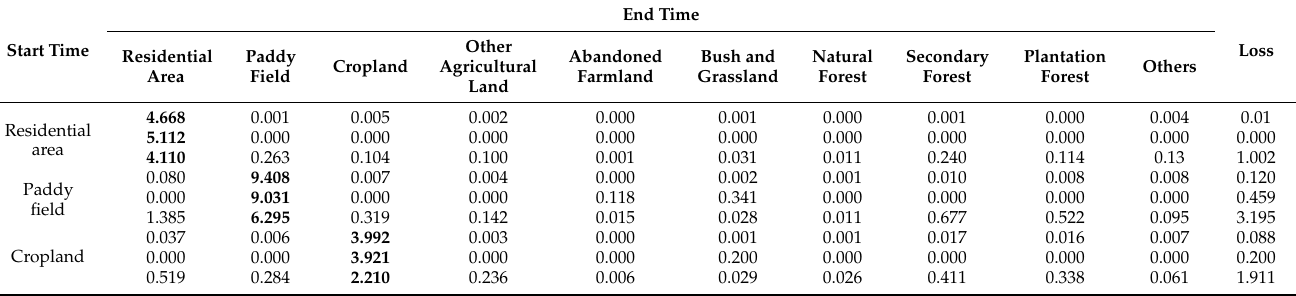
Table A2. Percent of transition cells from the start time to the end